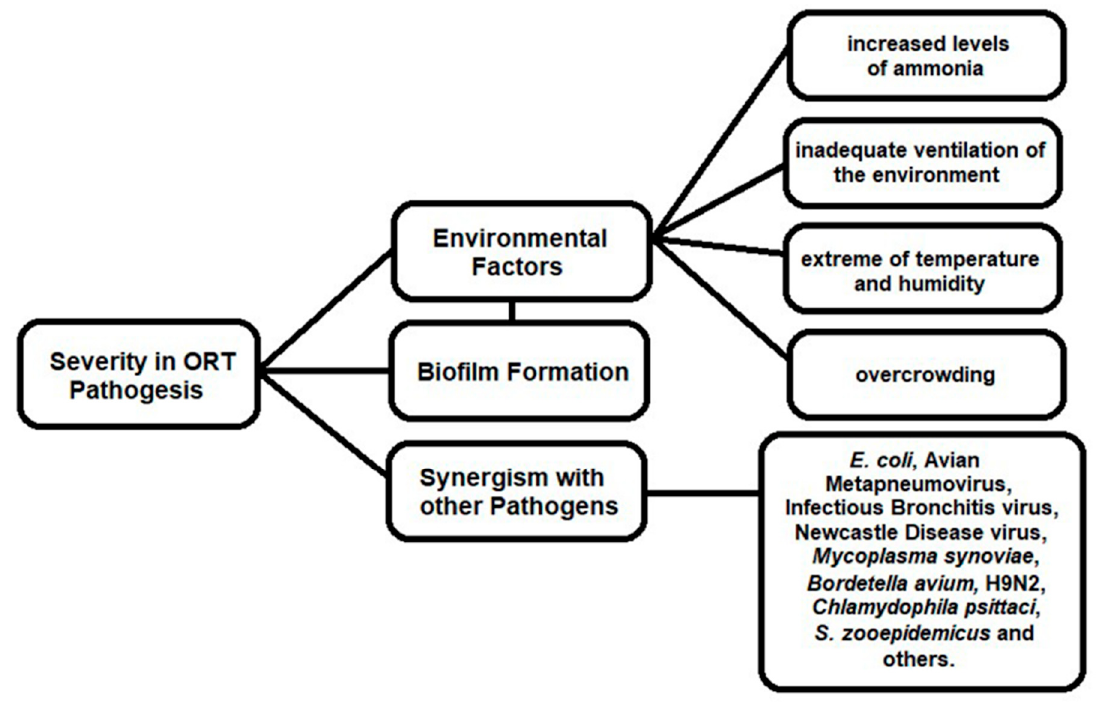
Figure 1. Factors involved in Ornithobacterium rhinotracheale (ORT) pathogenesis.